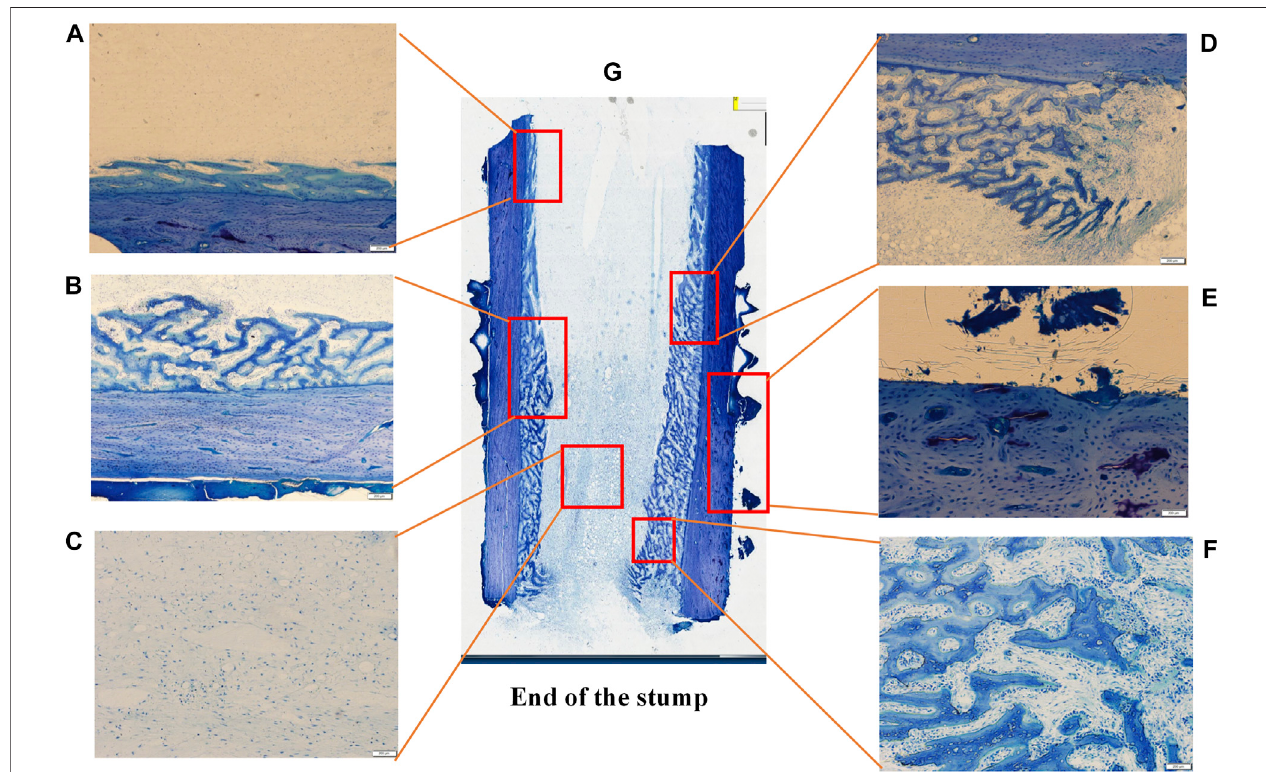
FIGURE8| Histologicalsectionsandtoruidinebluestainingoftheundecalci fi edbonesampleaftertheexternalcapimplantremoved,observedusingaHistological microscope (magni fi cation ×4). Images (A F) were the magni fi cation of the areas in the red box in image (G) , showed the bone formation in different areas.